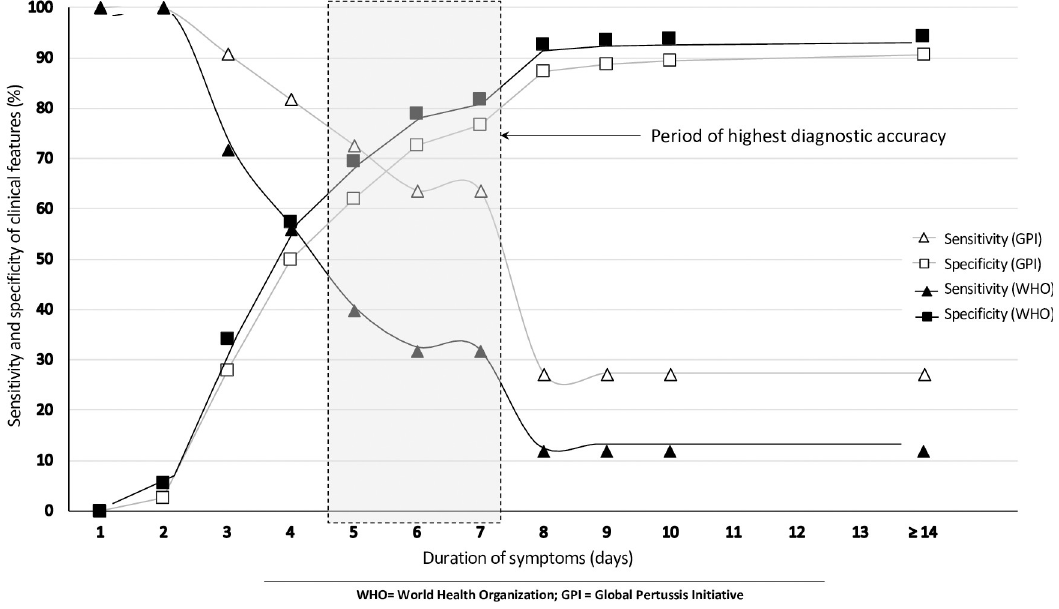
Fig 3. Sensitivity and specificity of clinical features in the diagnosis of pertussis with changing